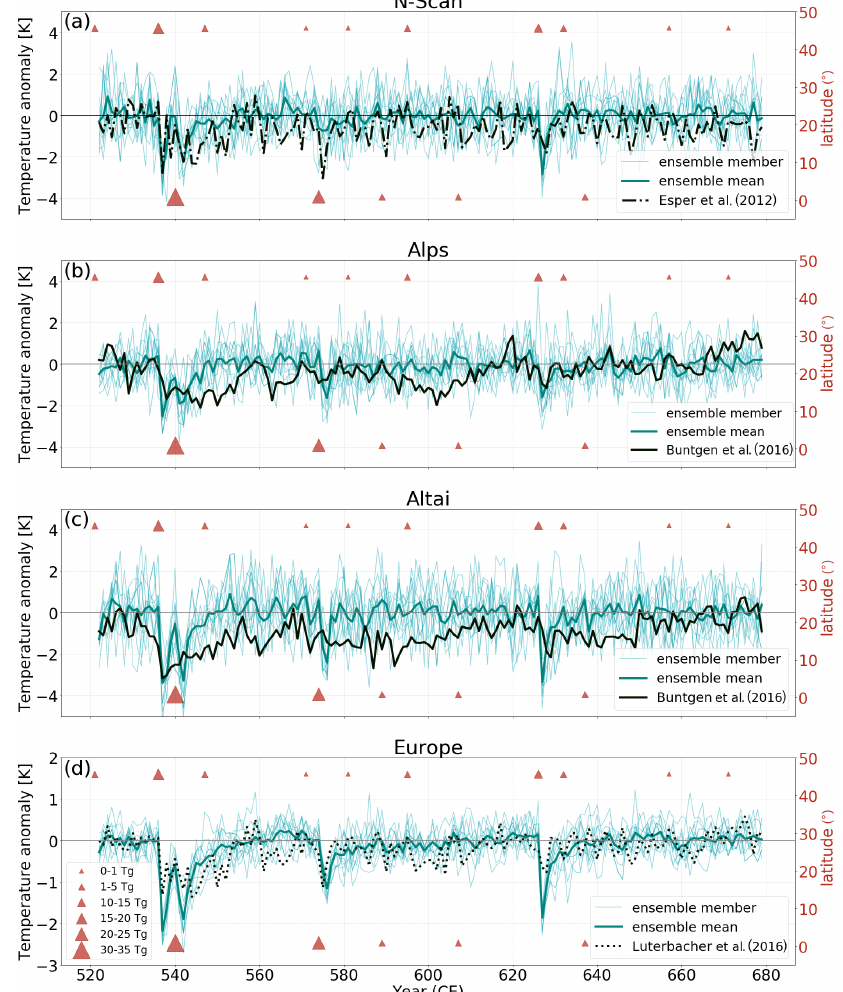
Figure A3. Model–tree ring comparison for (a) northern Scandinavia (N-Scan) (Esper et al., 2012b), (b) the Alps and (c) the Altai (Büntgen et al., 2016), and Europe (Luterbacher et al., 2016). Mean anomalies are calculated for the 1–1850CE reference period. The red triangles represent the volcanic eruptions from the model forcing (Toohey and Sigl, 2017) according to their latitude (tropical or NH extratropical), and the size of the triangle corresponds to the estimated range of sulfur [TgS] injected into the stratosphere.